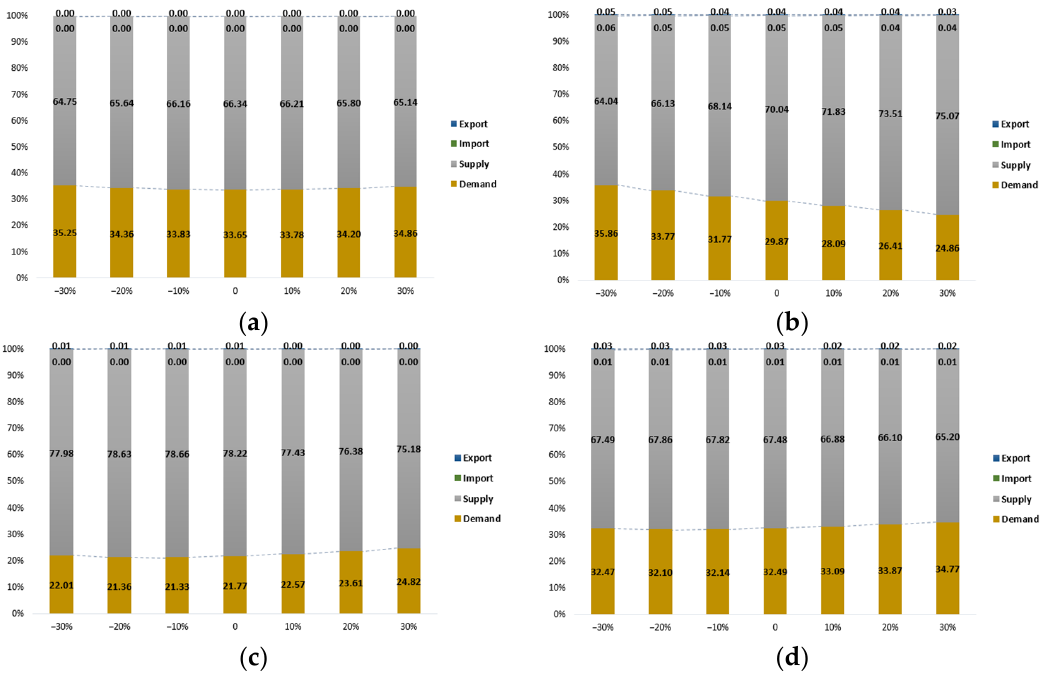
Figure 3. Numerical simulation results of cabbage. ( a ) Spring cabbage; ( b ) Highland cabbage; ( c ) Fall cabbage; ( d ) Winter cabbage.